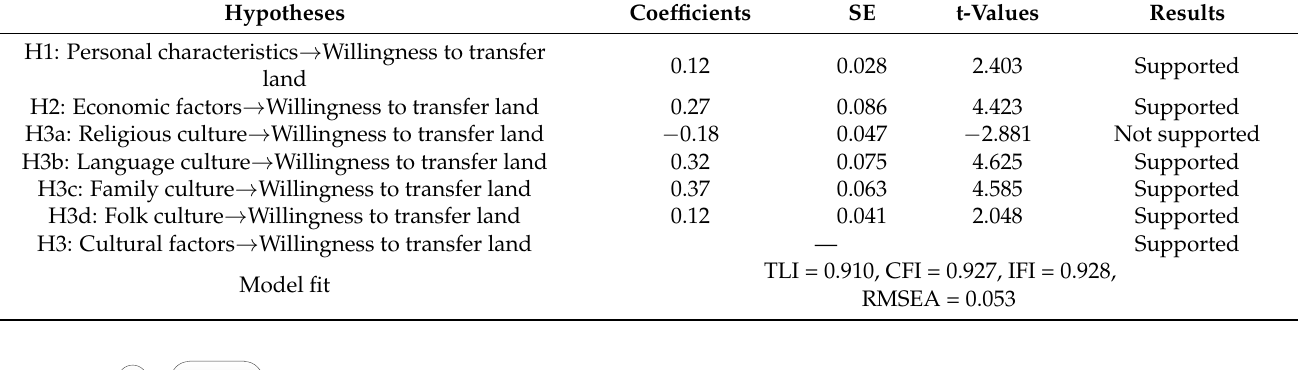
Table 5. Results of structural equation modeling.